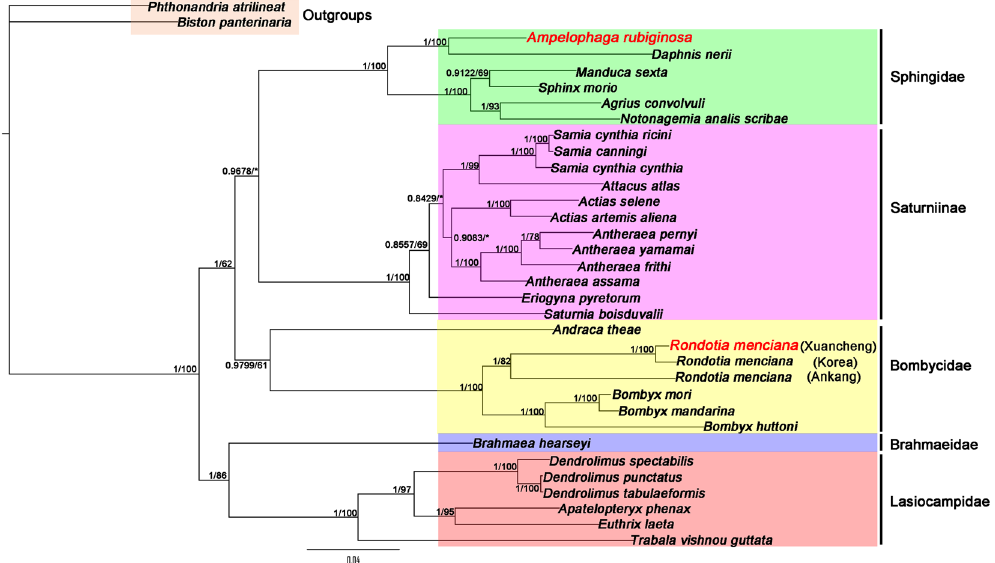
Figure 5. Phylogenetic tree derived for Bombycoidea using BI and ML analyses based on amino acid sequences and using MAFFT for alignment. Bayesian posterior probability (BPP) and bootstrap values (BP) of each node are shown as BPP/BP, with maxima of 1.00/100.